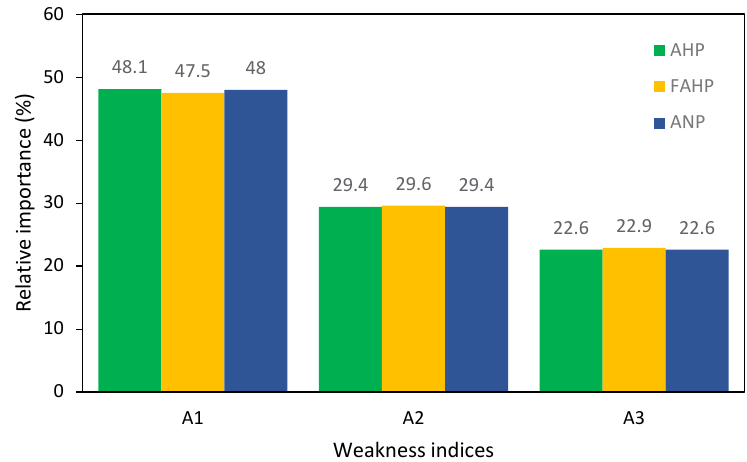
Fig. 4: Comparison of relative importance (weights) of second-level weakness indices of A using AHP, FAHP, and ANP approaches